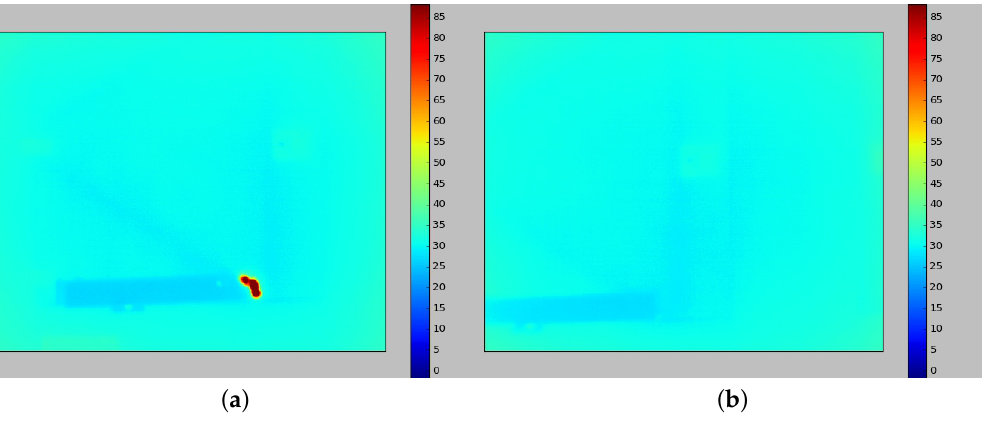
Figure 17. 2D thermal pictures of the generator. ( a ) Hotspot in 2D thermal reading with temperature scale. ( b ) 2D thermal reading with no